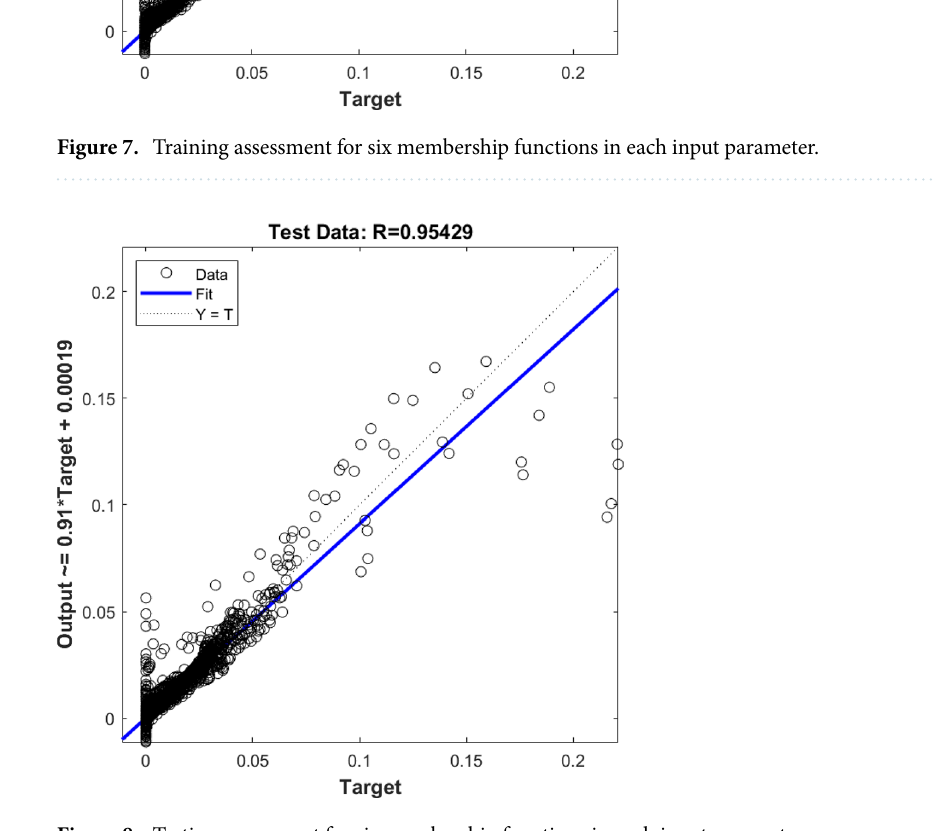
Figure 8. Testing assessment for six membership functions in each input